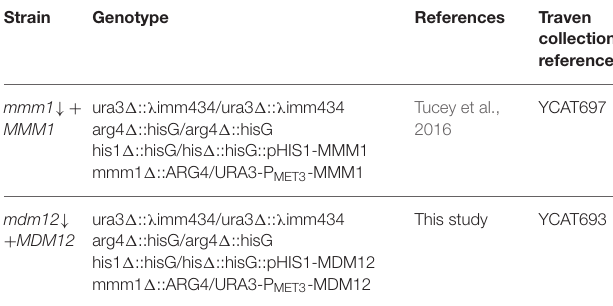
with 125 ng/ml caspofungin for the times indicated in the Figure. For ERMES shutdown strains mmm1 ↓ , mdm10